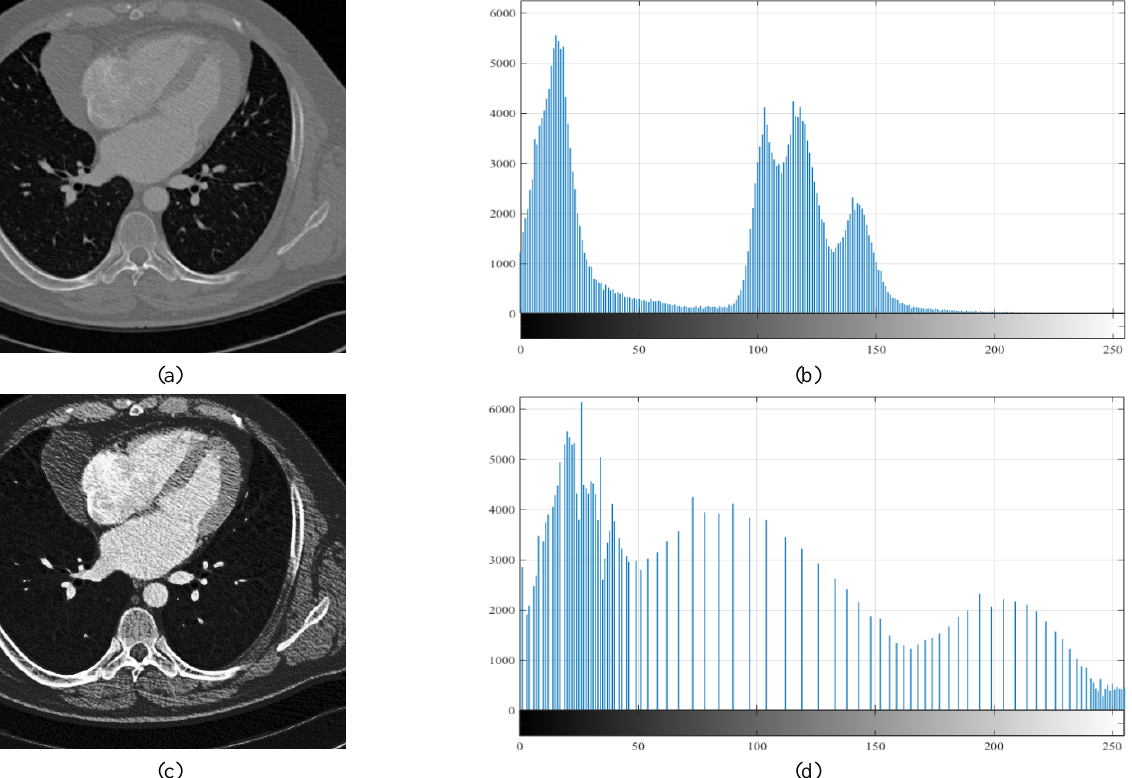
Figure 2. Image enhancement using the bimodal Gaussian function: source image (a) and its histogram (b), enhanced image (c) and its histogram